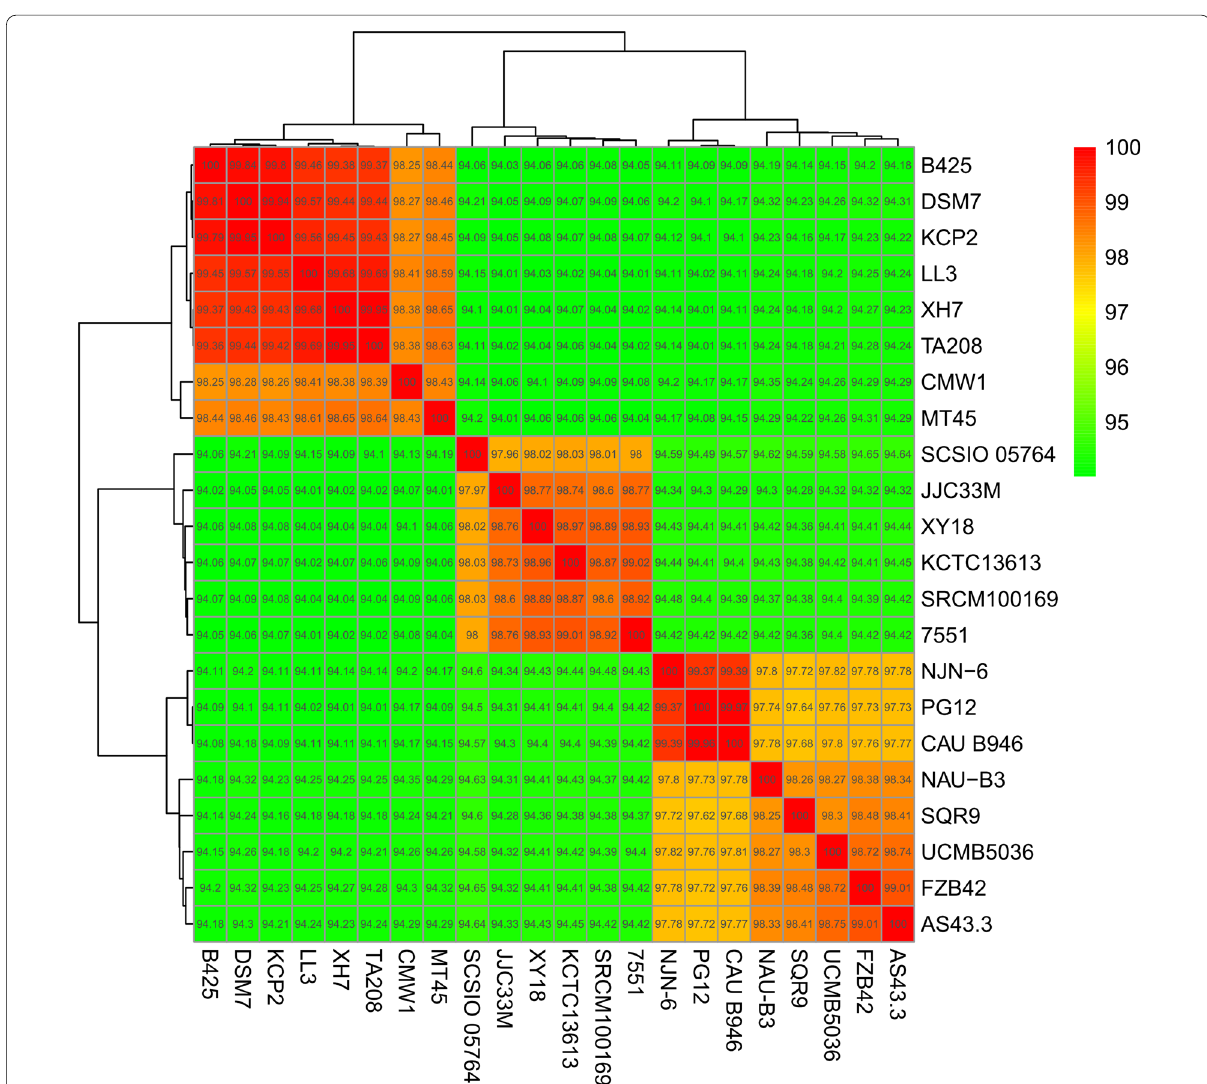
Fig. 2 Heat-map based on average nucleotide identity values calculated between genomes of 22 strains of the B. amyloliquefaciens